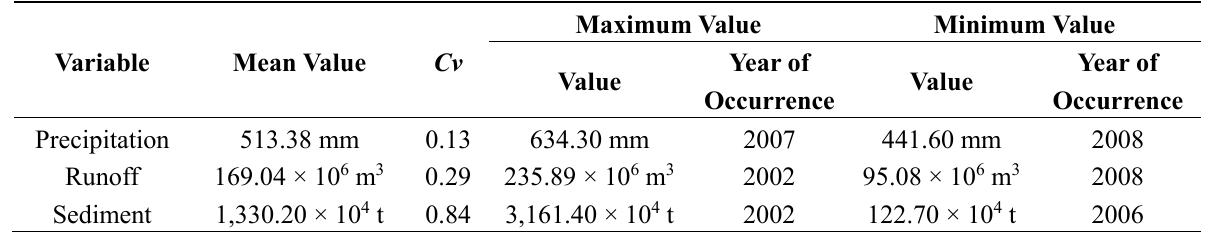
Table 2. Annual characteristics of precipitation, runoff and sediment yield during